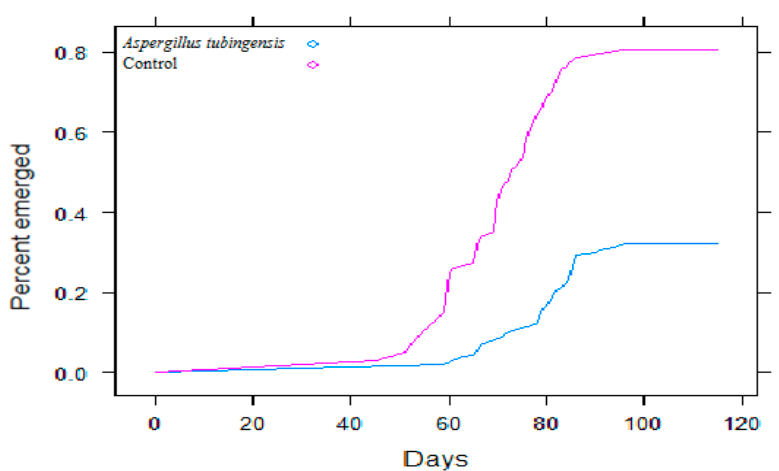
Figure 3. Emergence of date palm seedlings from 100 seeds of cv. ‘Halawi’ inoculated with a single isolate of A. tubingensis , versus 100 seeds without A. tubingensis (controls). Note that the effect of A. tubingensis reproduces the effect on emergence that we saw in the prior experiment, which was attributed more loosely to Aspergillus sect. Nigri (Figure 2).